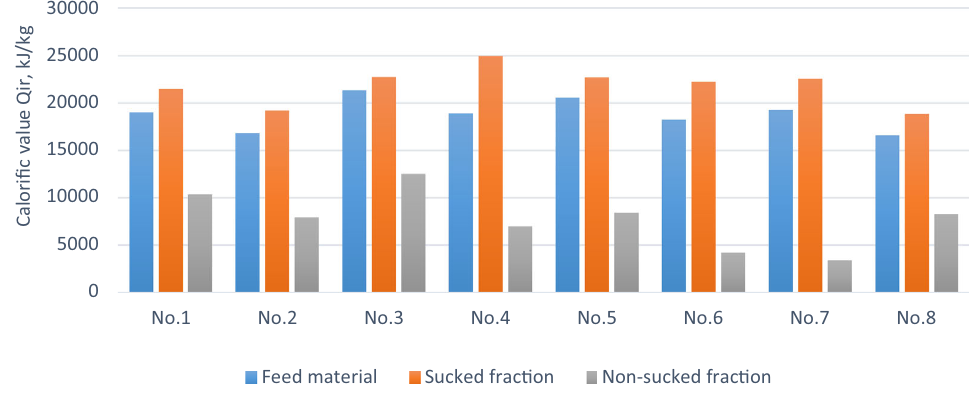
Fig. 11 Calorific value with respect to the origin of the feed material (grain-size class of 0–50 mm)